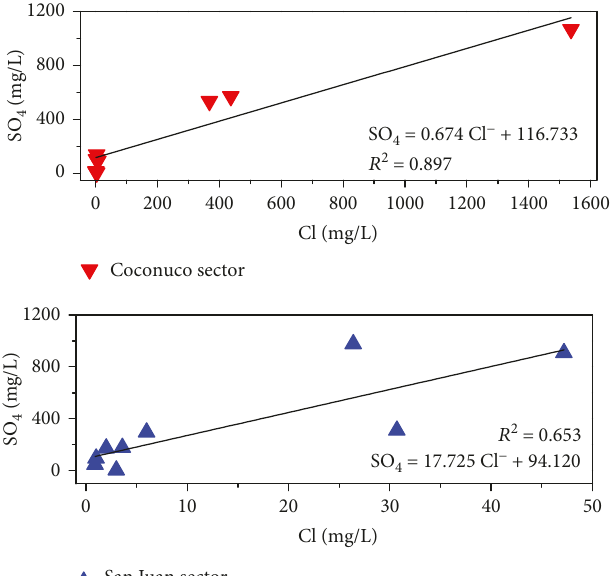
Figure 9: Relation between Cl and SO4.